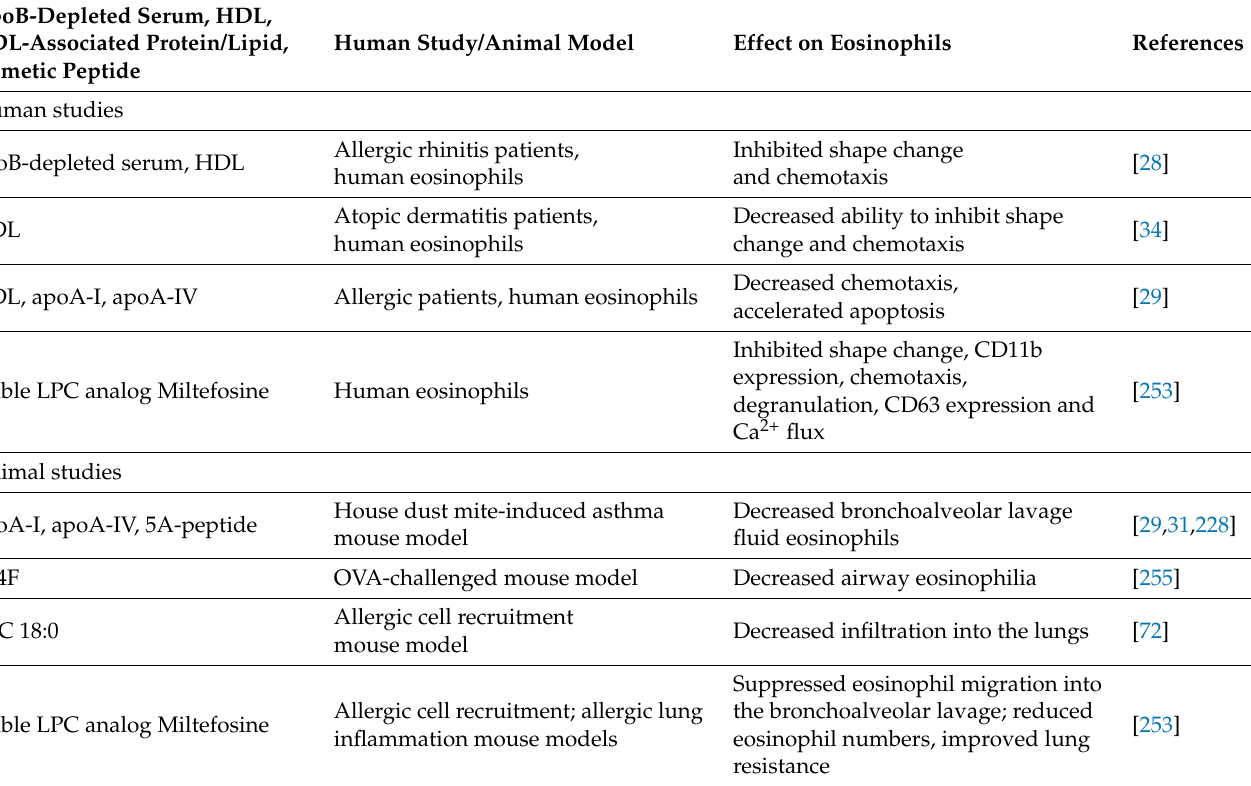
Table 4. Effects of apoB-depleted serum, HDL, HDL-associated apolipoproteins and lipids or mimetic peptides on eosinophil function in human studies utilizing primary eosinophils and in studies utilizing animal